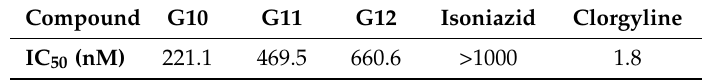
Table 2. Monoamine oxidase A (MAOA) inhibitory activity of G10 – G12 in LNCaP cells (IC 50 , nM).